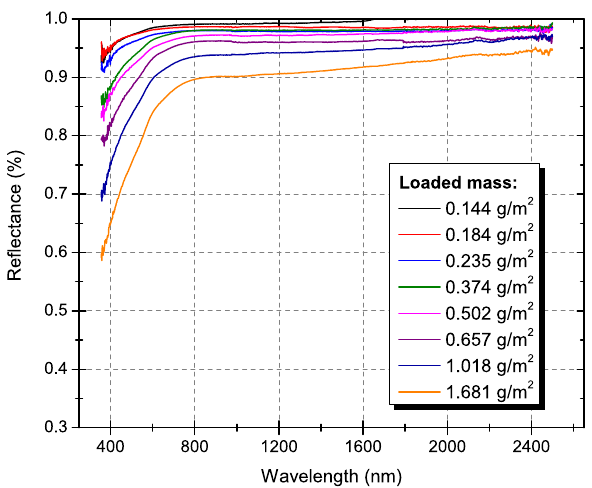
Figure 6. Spectral reflectance of the volcanic ash Eyjafjallajökull for fine filters according to the loaded mass per unit area σ of each filter in [gm − 2 ]. Each curve represents the average over 25 measurements of reflectance over the same filter. Uncertainties on the reflectance were estimated to be a maximum of 2.0% for the full wavelength range. These uncertainties arise mainly from non- flatness of the filters when placed for